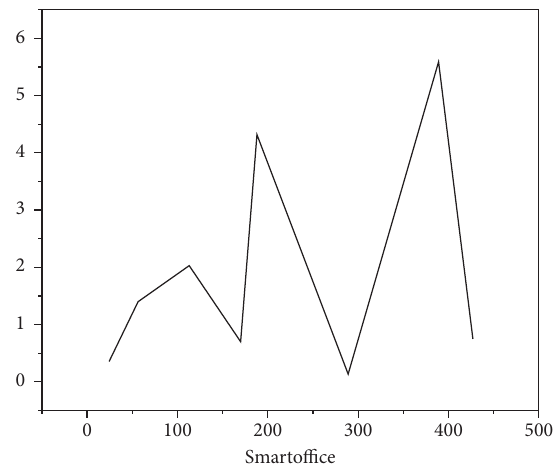
Figure 5: Comparison of test frequency response Table 1: Test frequency response function error.